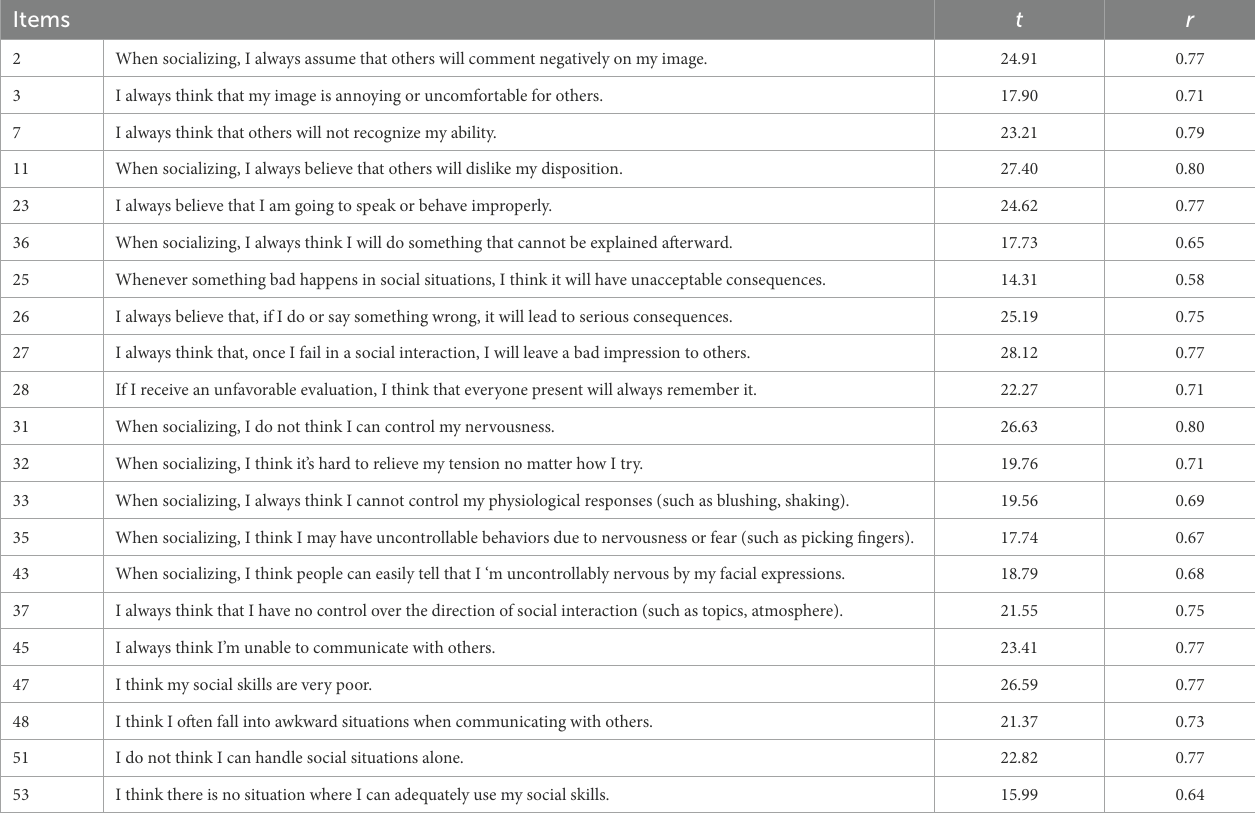
TABLE 1 The items analysis results for the final SACS-CS.